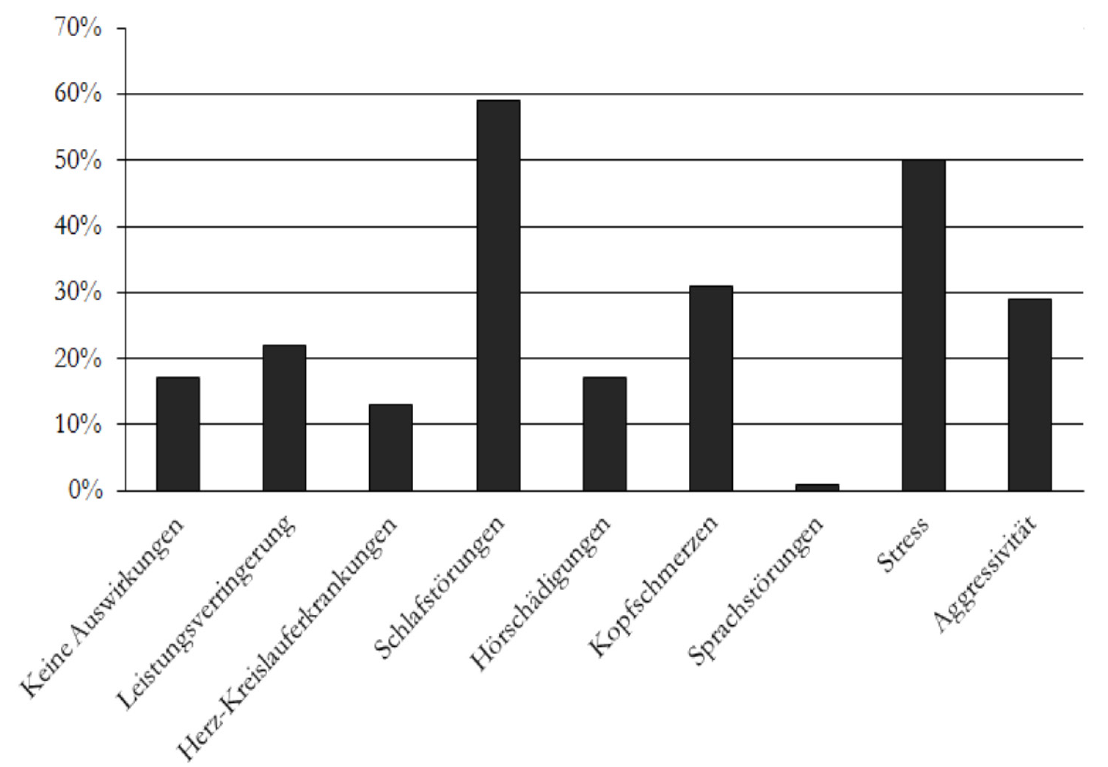
Figure 3: Health effects due to traffic noise according to residents (N = 211, multiple replies